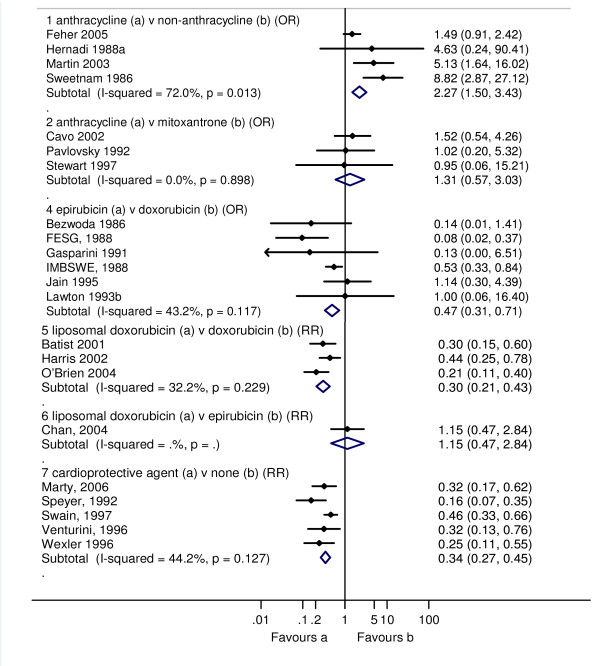
Clinical and subclinical cardiotoxicity in RCTs where cardiotoxicity outcomes could not be categorised as one or the other. The open diamond represents the pooled Peto Odds Ratio and 95% CI for treatment comparisons 1, 2 and 4, and relative risk (RR) with 95% CI for comparisons 5-7. I-squared represents the proportion of variability between studies in excess of that expected due to chance, and p = probability that differences between study estimates are due to chance.